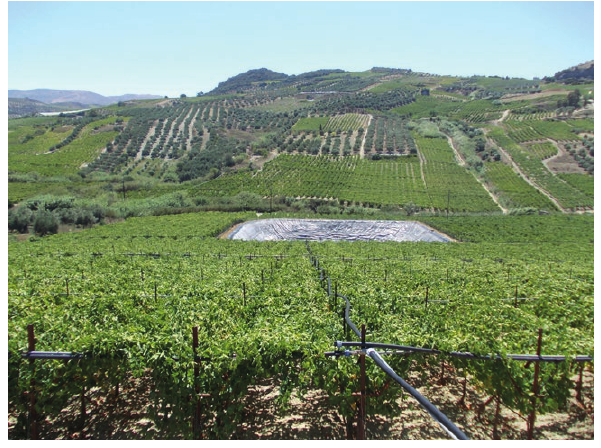
Figure 3. Typical landscape of adjacent vineyards and olive orchards in Crete, Southern Greece, which allows the inoculum